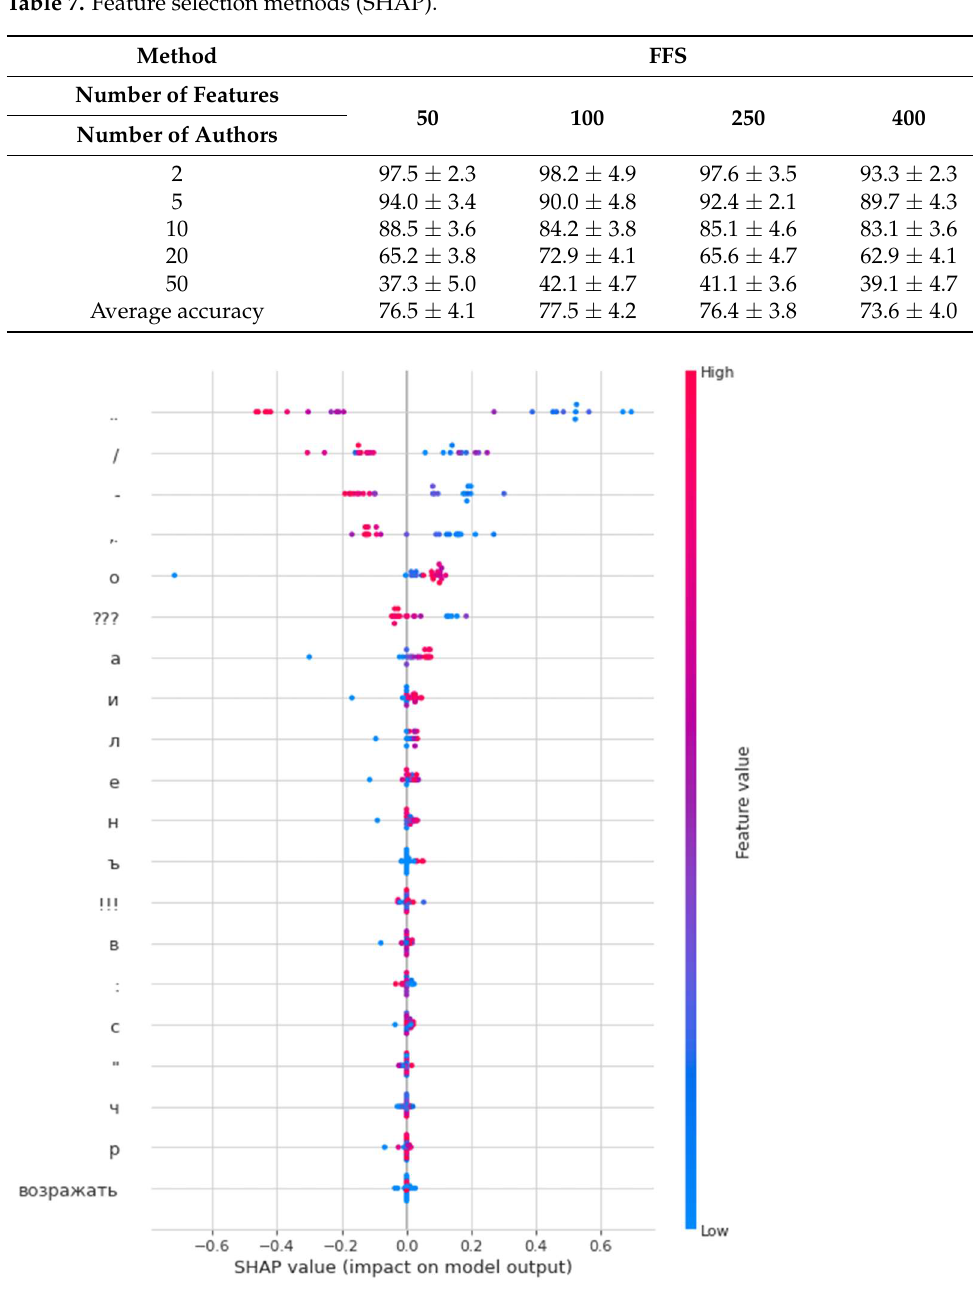
Table 7. Feature selection methods (SHAP).